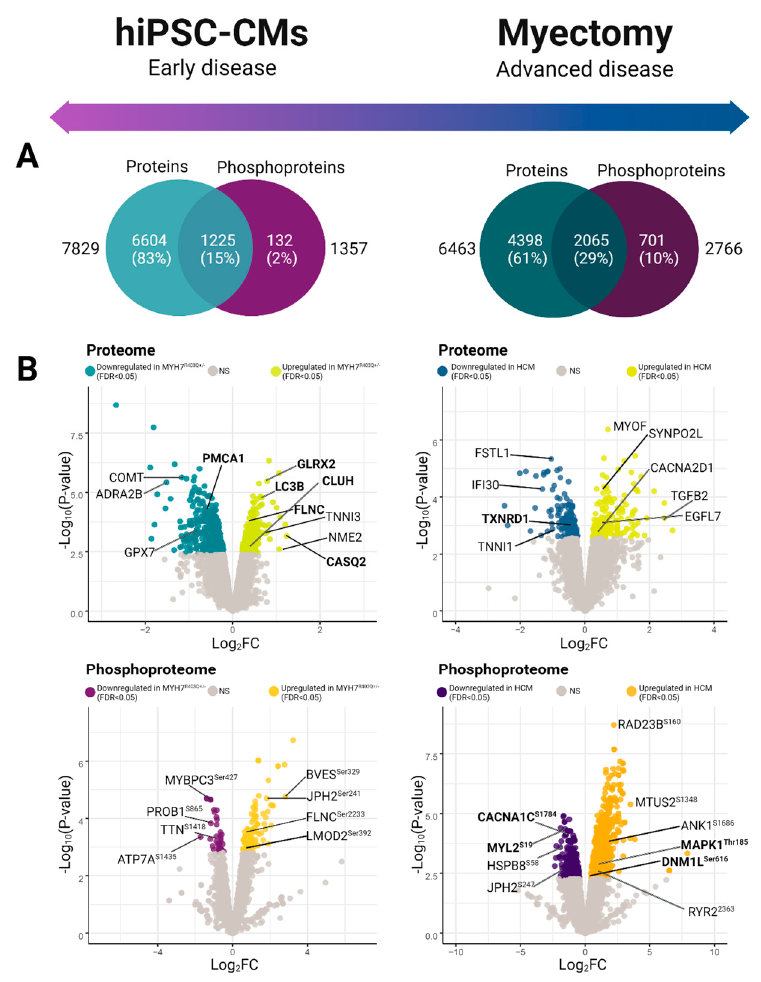
Figure 2. Global phosphoproteomic and proteomic expression profiles. ( A ) Venn diagrams depicting total feature coverage (high confidence proteins and phosphoproteins) quantified in hiPSC-CM (left) versus patient (hypertrophic cardiomyopathy specimens and healthy control) myectomy specimens (right). ( B ) Volcano plots of differentially expressed features. Plots show negative log-transformed p -values (moderated t -test) against log2-transformed fold-change difference measured between the mutant and wild-type specimens. Non-grey values highlight significant difference between groups (moderated t -test; FDR adjusted p < 0.05).